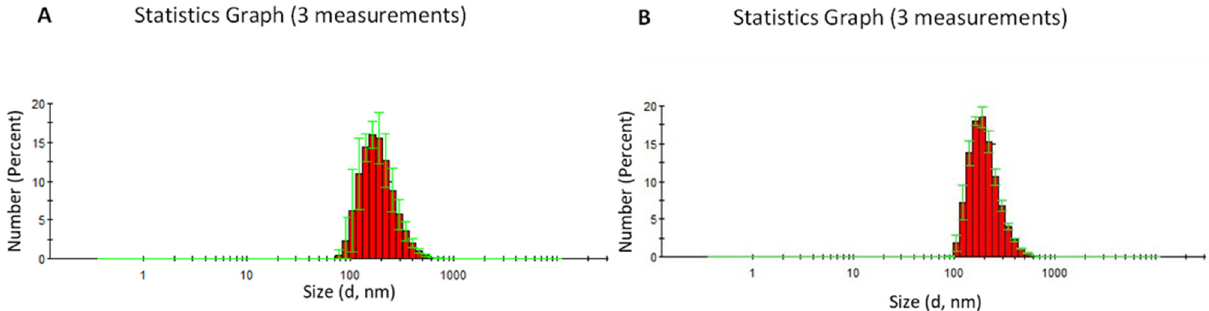
Figure 6. DLS size distribution of the CaNP 7 nanoparticles. The particle size was determined by the DLS method to be 204 ± 8 nm, with a polydispersity index (PDI) of 0.14 ± 0.02 ( A ). DLS size distribution of CaNP 7 nanoparticles after 90 days of storage. The particle size was determined by the DLS method to be 207 ± 4 nm, with a PDI of 0.11 ± 0.01 ( B ).